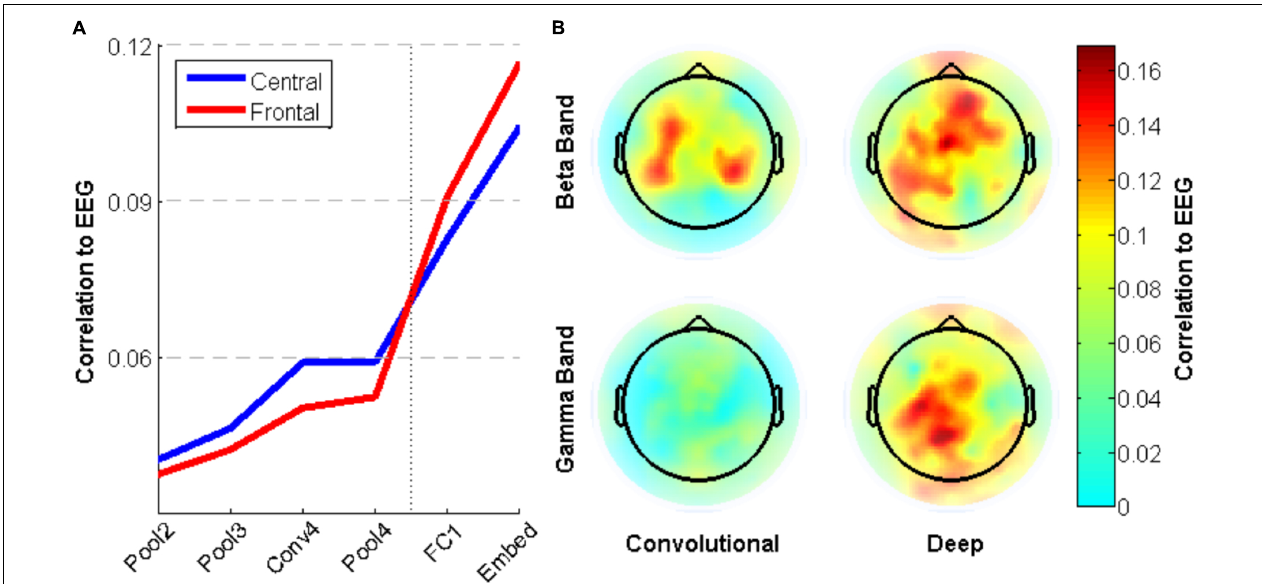
FIGURE 8 | Correlation between neural network activity and energy in EEG frequency bands for specific electrodes. (A) Average correlation between electrode activity across frequency bands for electrodes in central (near Cz) and frontal (near Fz) regions. (B) Correlation between beta/gamma band activity for individual electrodes and convolutional/deep layers of the neural